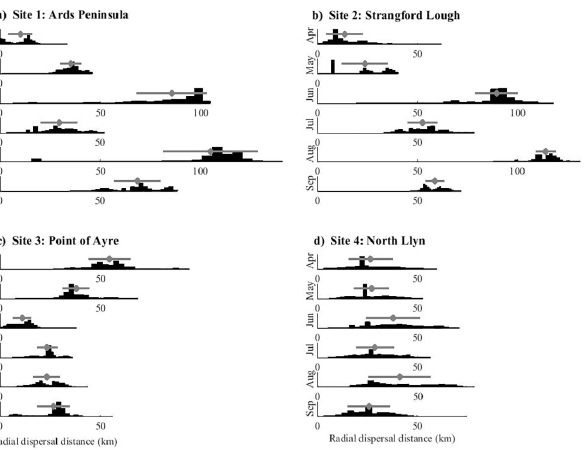
Fig 3. Histograms of radial dispersal distances for each simulated cohort of 10,000 larvae. Each Fig (a- d) displays histograms from six release dates (01 April — 01 September), released from the distinct source locations (Sites 1 – 4). Each bar in each histogram represents 400 particles (i.e., each histogram is split into 25 bars). The average radial dispersal for each cohort is shown with grey diamonds and horizontal grey error bars signify one standard deviation. Radial dispersal distance is defined as the 30-day source-to-sink shortest